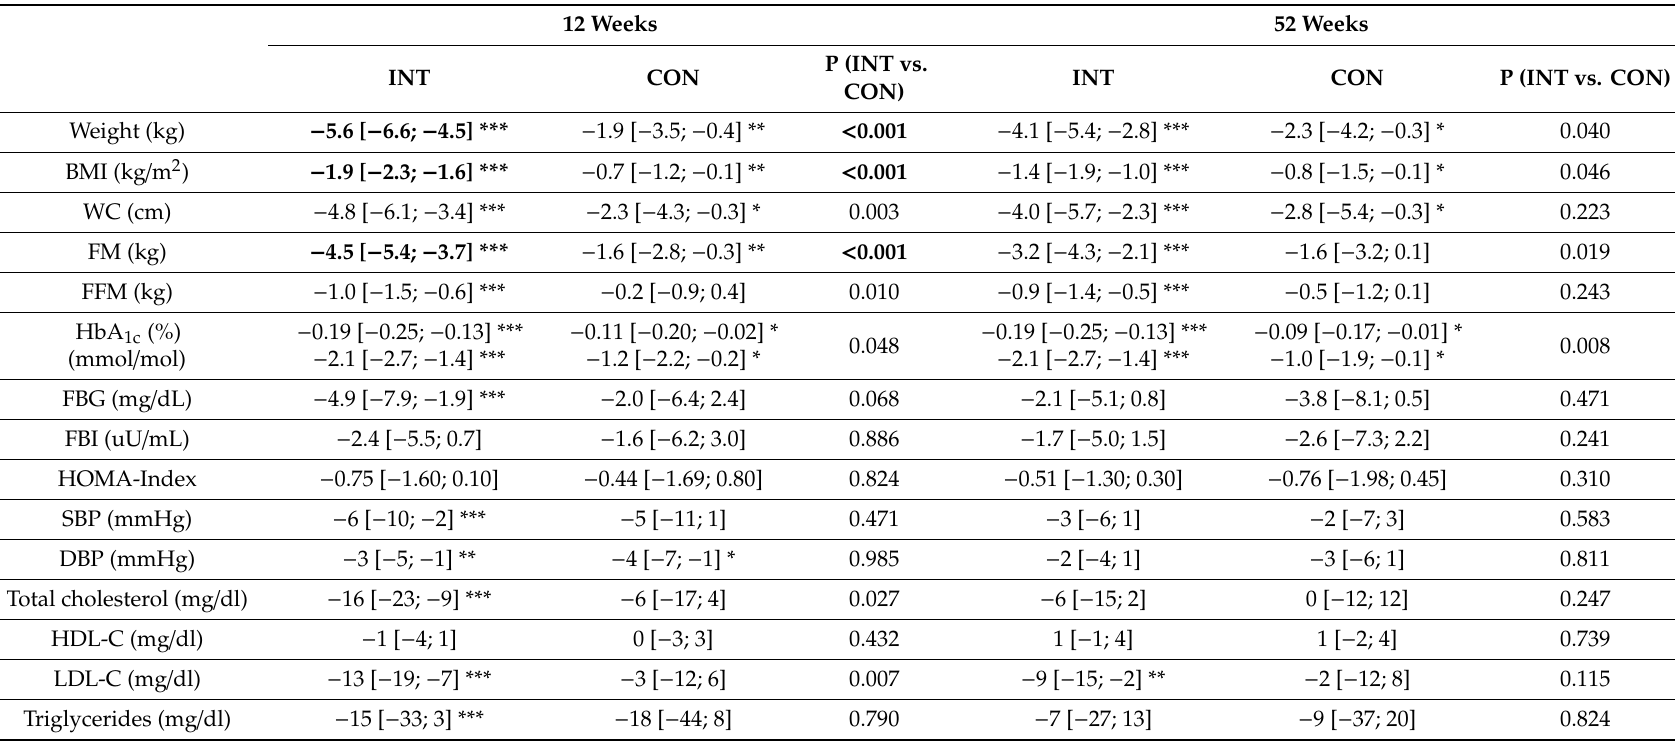
Table 2. Intra- and intergroup changes in the INT and CON groups after 12 and 52 weeks compared with baseline. 12 Weeks 52